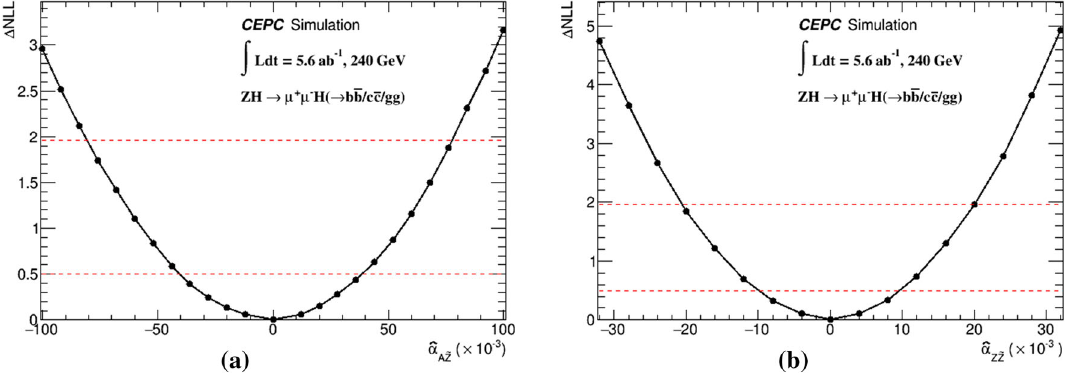
= 0), b (cid:16) NLL curve (fit to ˆ α with (cid:8) α A ˜ Z Z ˜ Z